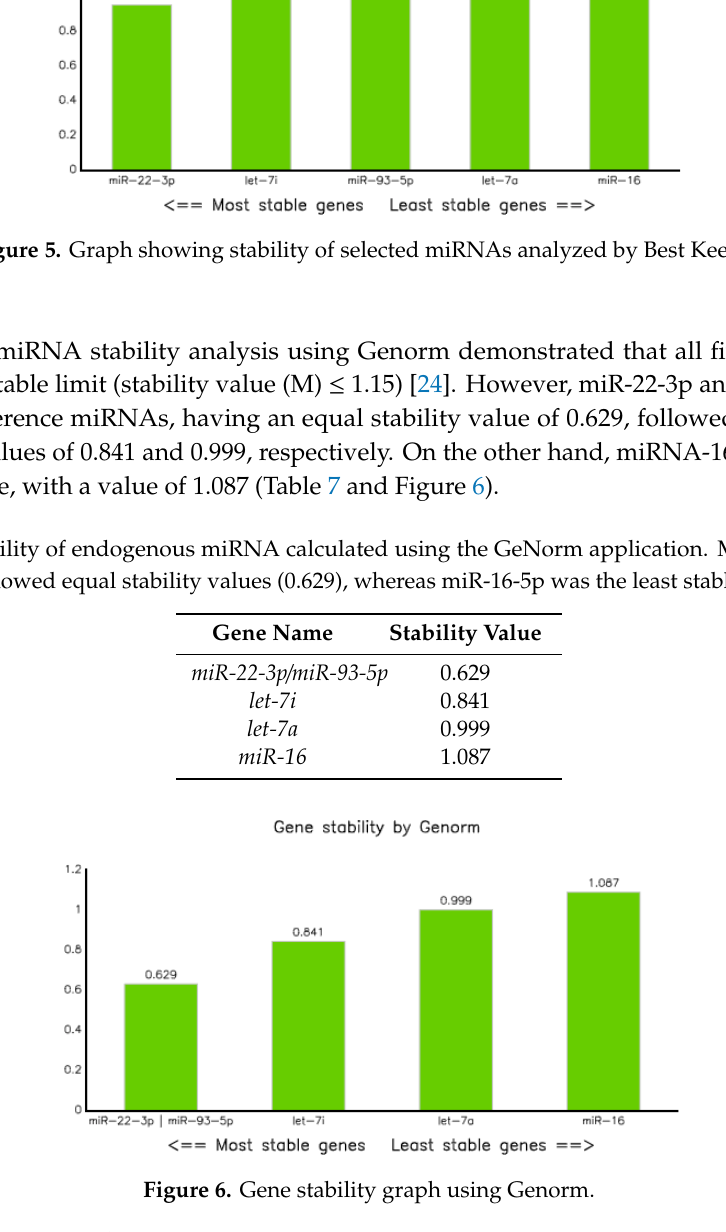
Figure 6. Gene stability graph using Genorm.